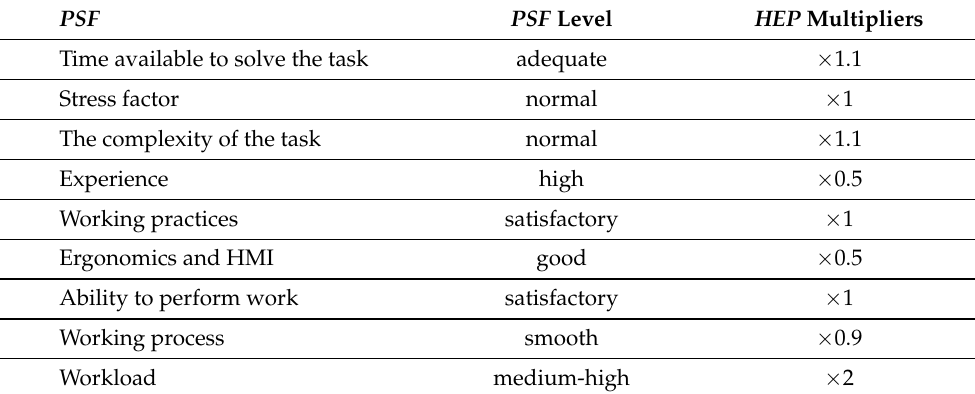
Table 7. PSF s overview for workplace